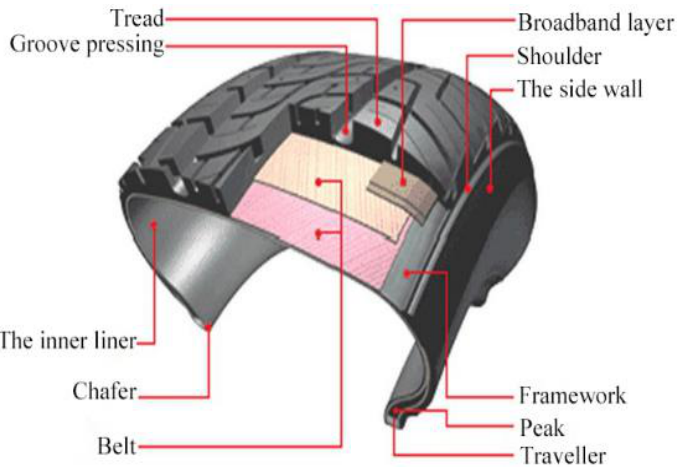
Figure 2. The structure of load radial tire.